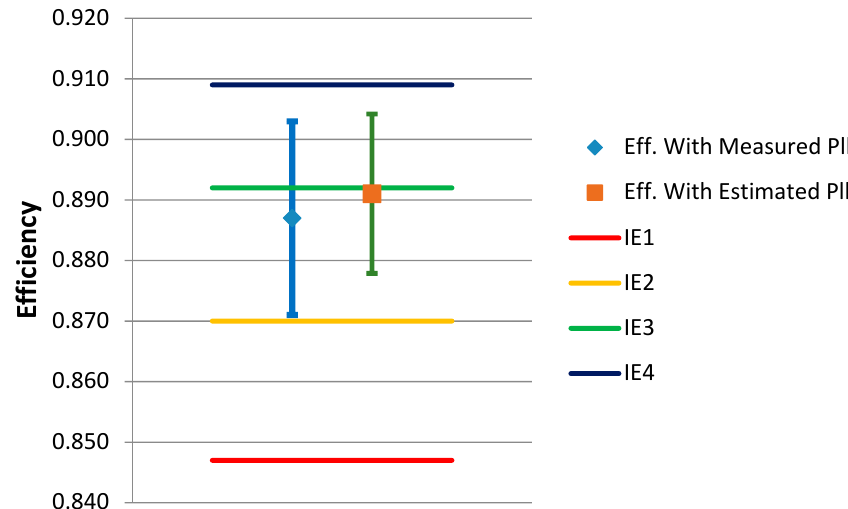
Figure 4. Comparison between the experimental efficiencies, with extended uncertainties coverage factor 2, and IE efficiency levels.